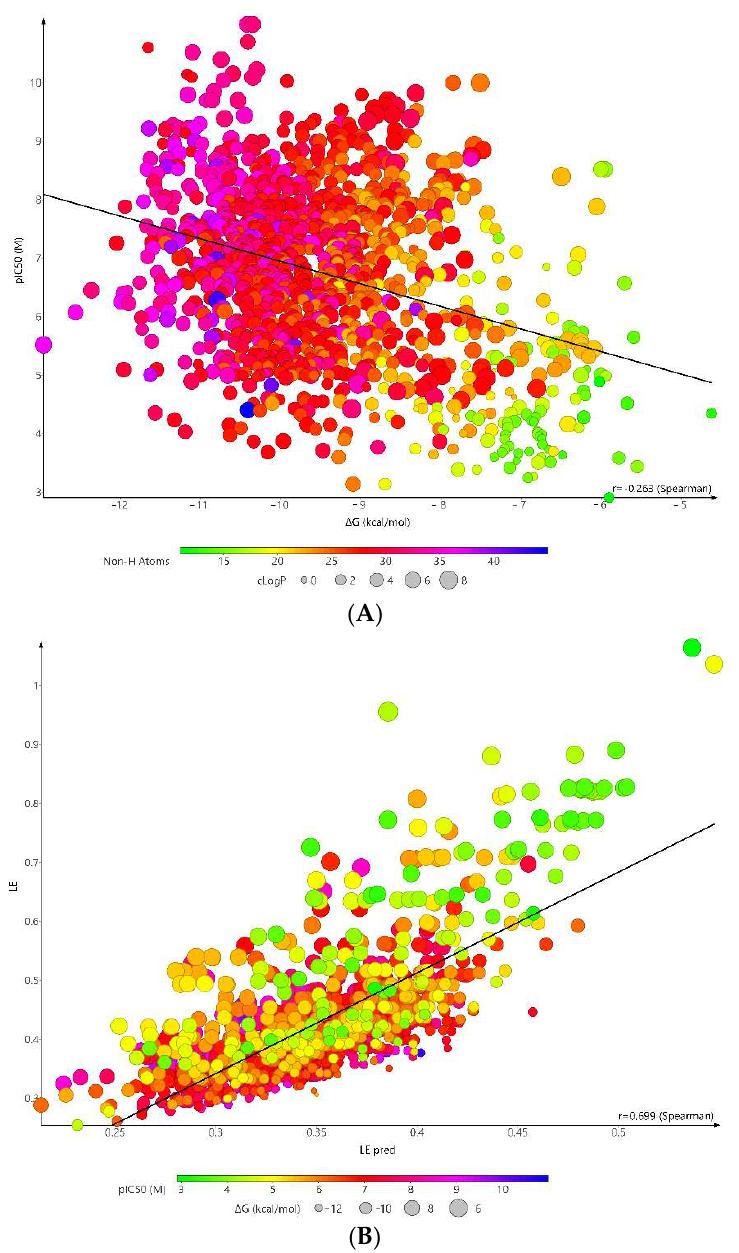
Figure 4. Correlation plot between experimental pIC 50 (M) and ( A ) binding energy (kcal/mol) (R 2 = 0.1118); ( B ) Ligand efficiency (R 2 = 0.533) of FAAH inhibitors in molecular docking simulations.